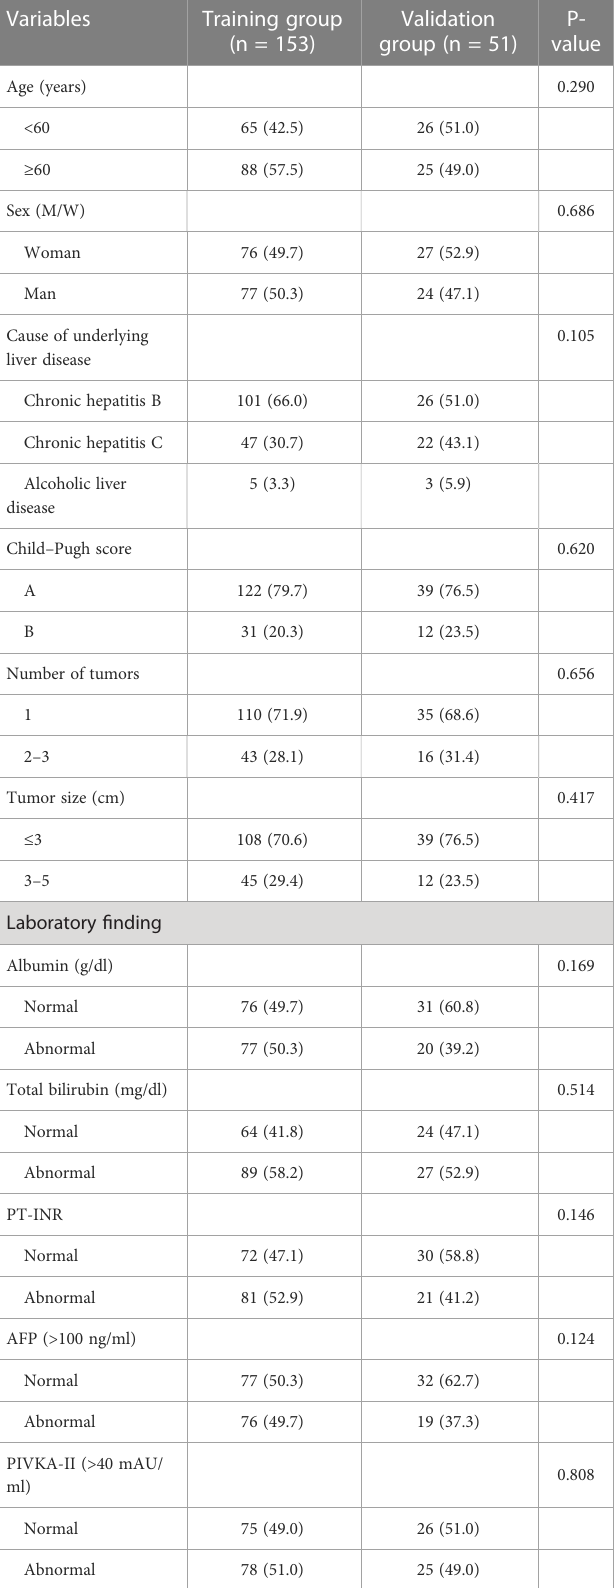
TABLE 1 The clinical, pathological, and radiological characteristics of the study